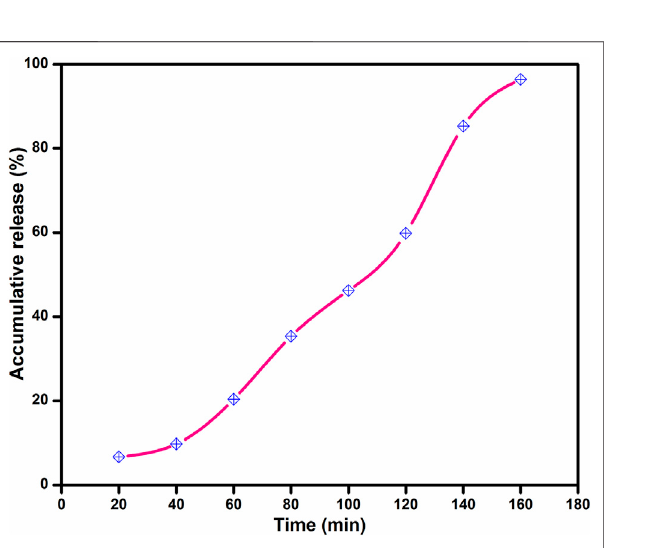
FIGURE 4 | Accumulative release of benzocaine in CPC-2.